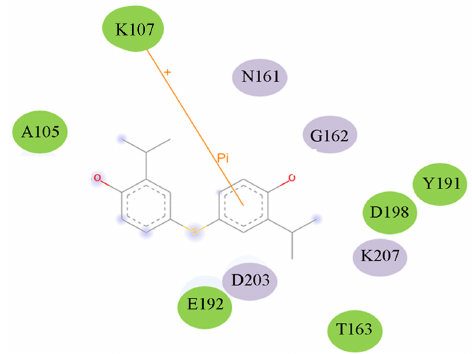
Figure 9. Active residues in the inhibitor 178 binding pocket. The color purple represents strong van der Waals (VDW) contact with178, and the color green represents electronic contact with178.